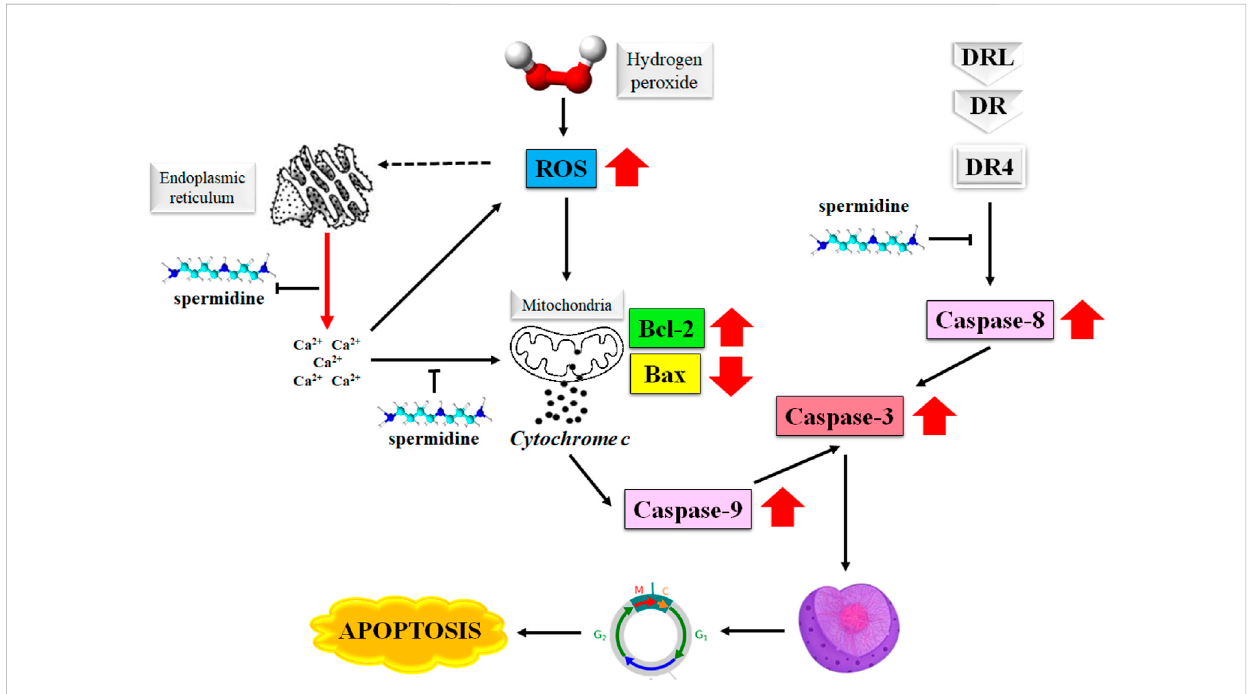
FIGURE 2 Mechanism of apoptosis induction by spermidine. Abbreviations: ROS, reactive oxygen species; Bax, Bcl-2 associated X protein; DR4, death receptor 4.